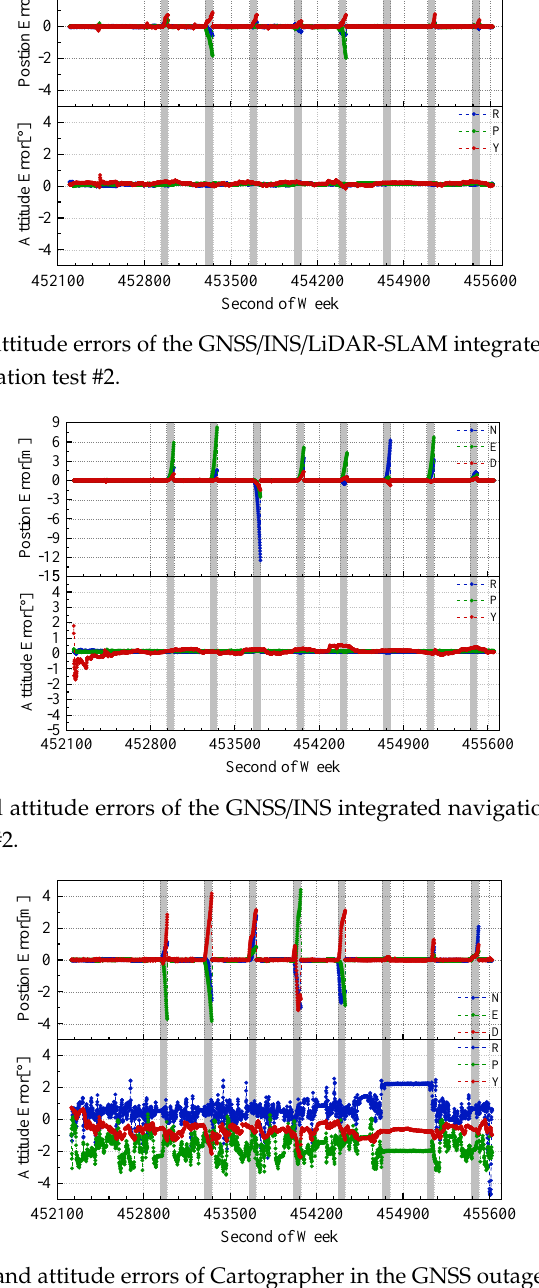
Figure 11. Position and attitude errors of Cartographer in the GNSS outage simulation test #2. T able 2 Errors statistics for the GNSS outage simulation tests.